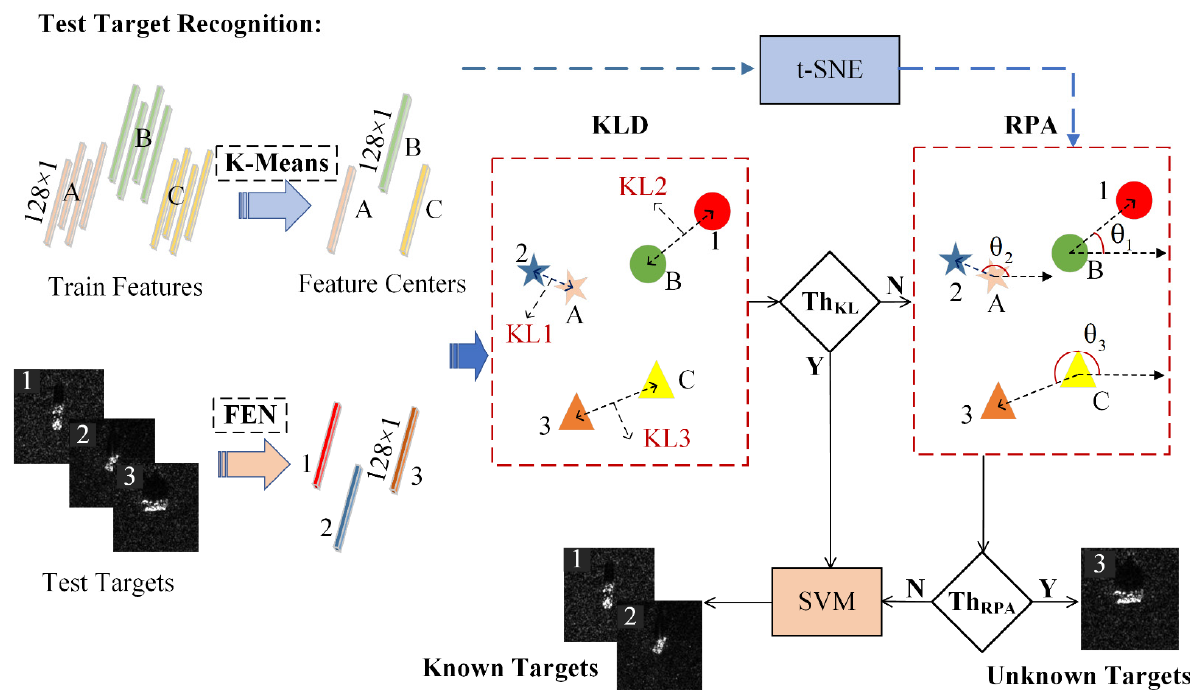
Figure 3. The principle of KLD–RPA joint discriminant algorithm. A, B, and C are known category centers, and target 1, target 2, and target 3 are test targets, among which target 1, 2 are known targets, and target 3 is an unknown target.